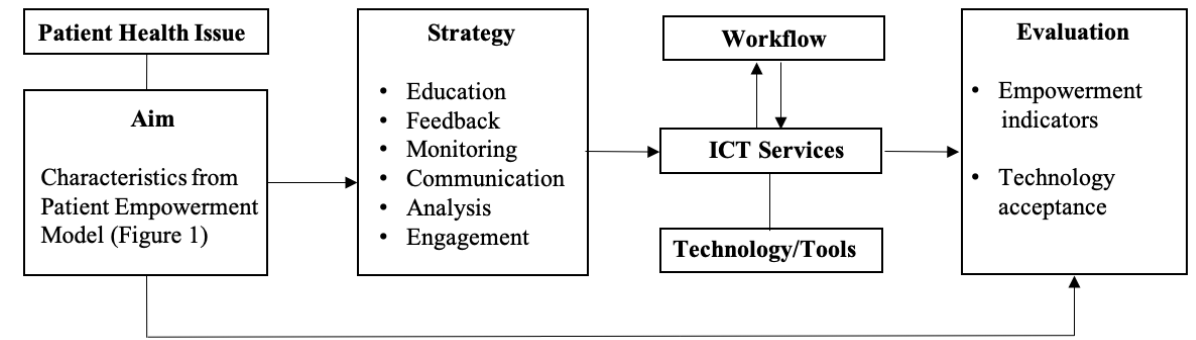
Figure 2. Information and Communications Technology for Patient Empowerment Model (ICT4PEM)